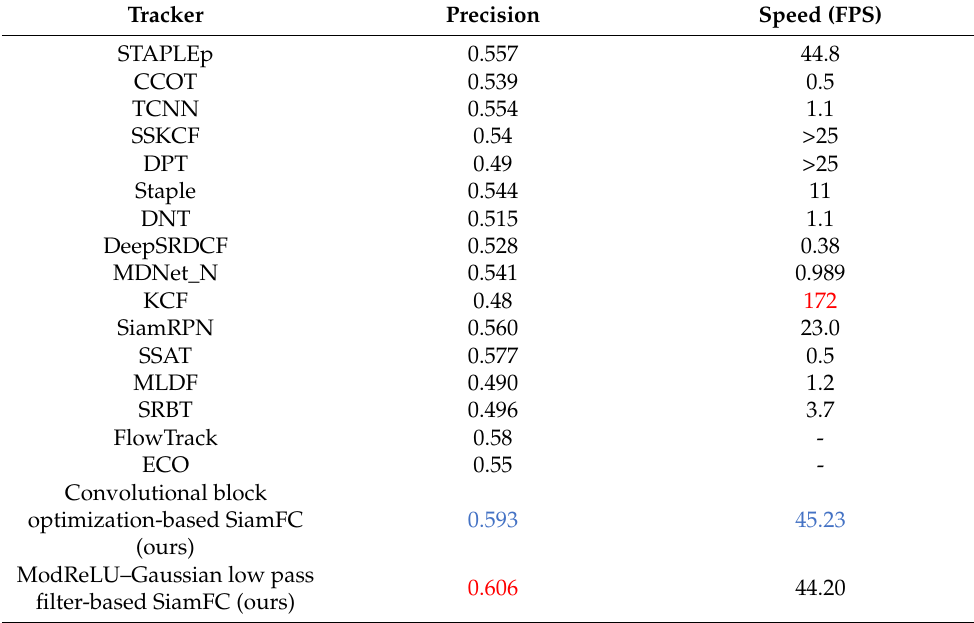
Table 7. Comparison results under precision and speed (FPS) with top performers on the VOT2016. The top two outcomes are highlighted in red and